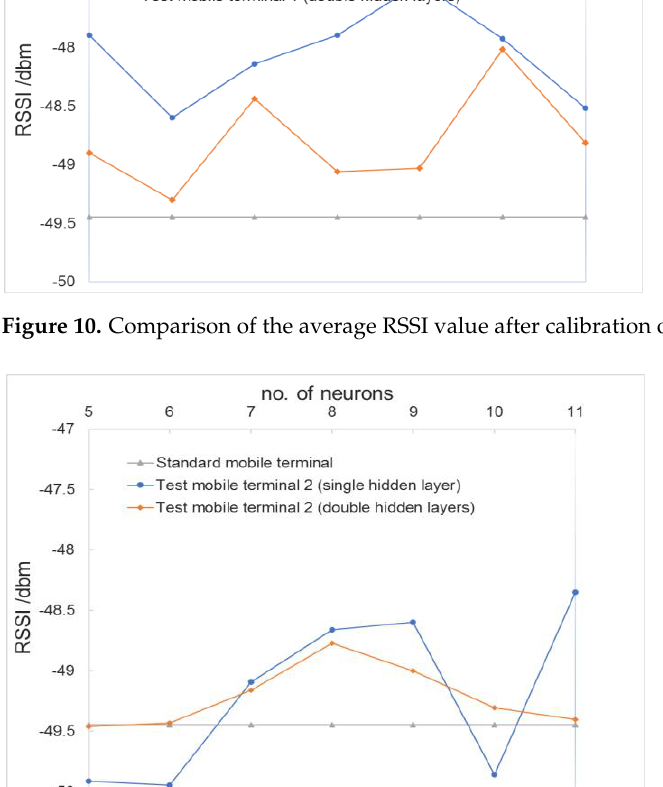
Figure 13. Comparison of average positioning error before and after calibration of test mobile ter- minal 2. According to Figures 12 and 13, for the two test mobile terminals, under the condition of the same number of neurons in each hidden layer, whether the hidden layer of the BPNN model is a single hidden layer or double hidden layers, the average positioning error reaches the minimum value when the number of neurons in the hidden layer is six and five, respectively. It can be seen from the above results that more neurons in the hidden layer do not mean better WOA-BPNN calibration algorithm results. Therefore, based on the above re- sults, and considering the problem of algorithm efficiency, we adopt the BPNN model with double hidden layers and six neurons in each hidden layer for the subsequent exper- iments. 3.4. Trajectory Positioning Points Based on the WOA-BPNN model established in the Section 3.3, and after processing the real-time positioning results of the two test mobile terminals, their trajectory position- ing points are shown in Figures 14 and 15.